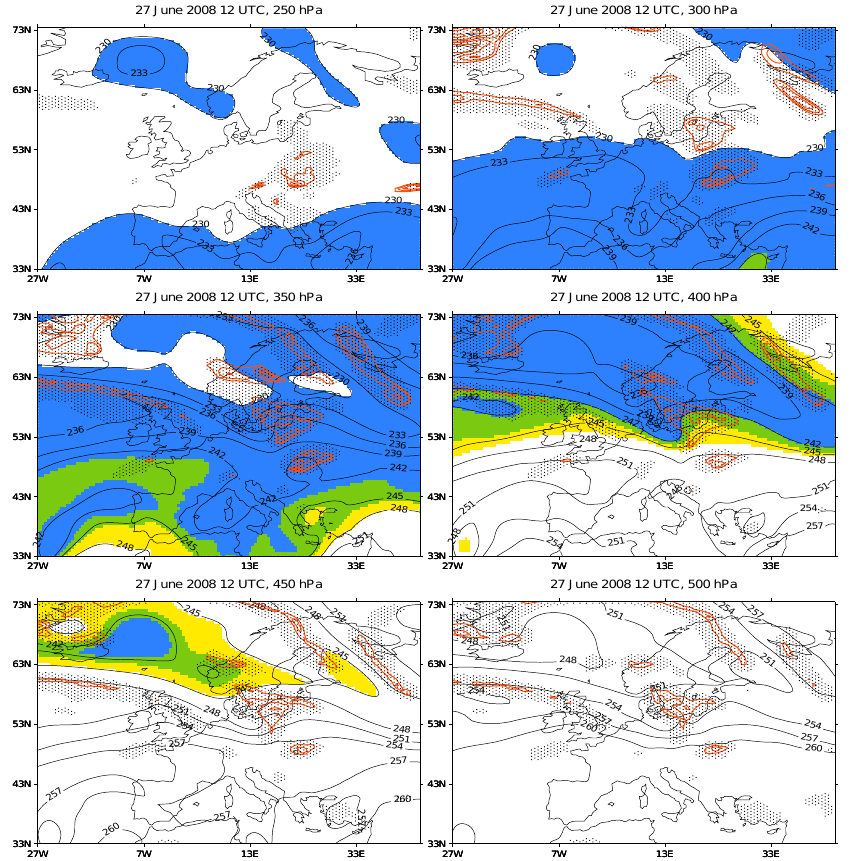
Fig. 3. Regions over Europe that are conditioned to formation of aerodynamic contrails on 27 June 2008, 12:00UTC. White colour signifies too cold or too warm temperatures for aerodynamic contrail formation, the three colours correspond to pressure drop values of -60, -50, and -40 hPa (yellow, green, and blue, respectively). Stippling shows areas with clouds (cloud fraction exceeding 0 . 1 ), and the red contours mark ice supersaturated regions, with contour levels starting at ice saturation and incrementing by 5% relative humidity with respect to ice. Standard pressure levels increase from top left (250 hPa) to bottom right (500 hPa).